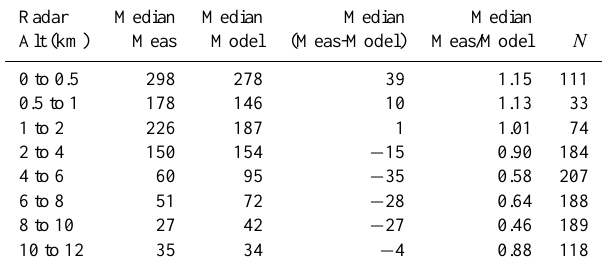
Figs. 5–8 where we plot altitude binned time coincident TD- LAS measurement-model comparisons for four different ge- ographic locations spanning both mission phases. We